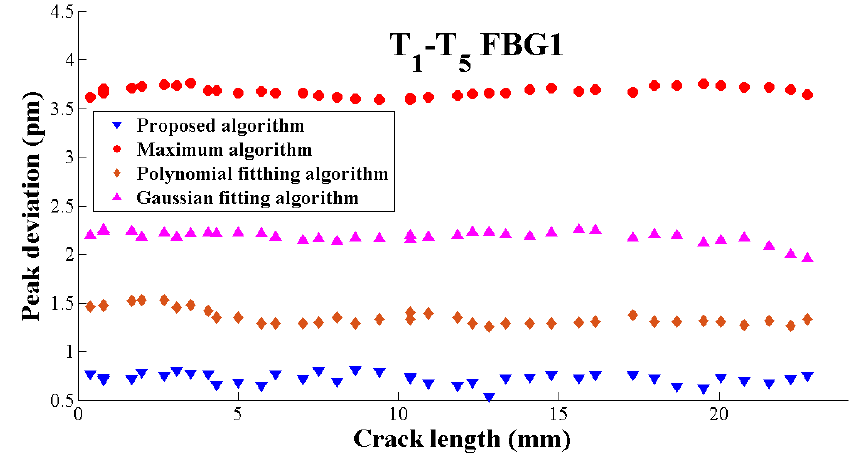
Figure 11. The relative error of five peak seeking algorithms at different crack lengths. ( a ) The relative of five peak seeking algorithms in FBG1, ( b ) The relative of five peak seeking algorithms in FBG2.